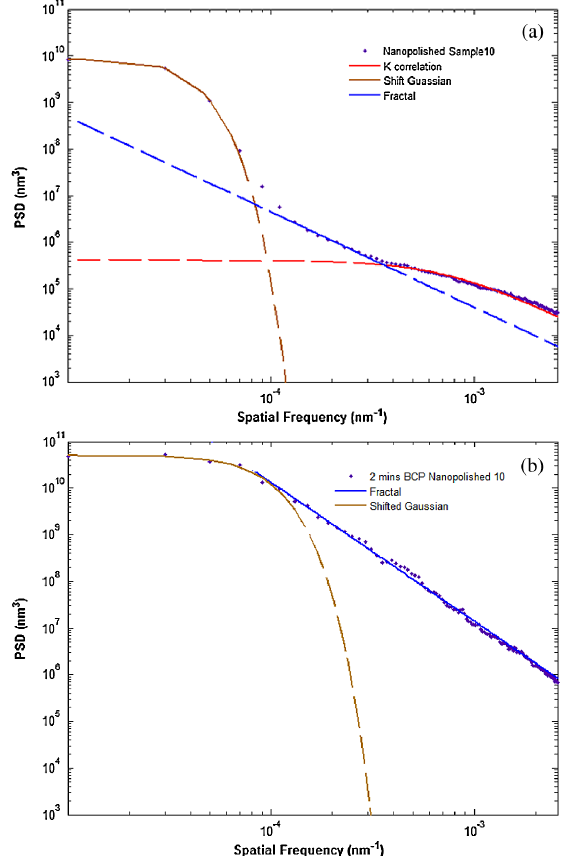
FIG. 14. Averaged 1D PSD for nanopolished fine-grained ma- terial: (a) as received and (b) after 6 (cid:1) m removal by BCP. The range of fitting for each component is indicated by the solid line.